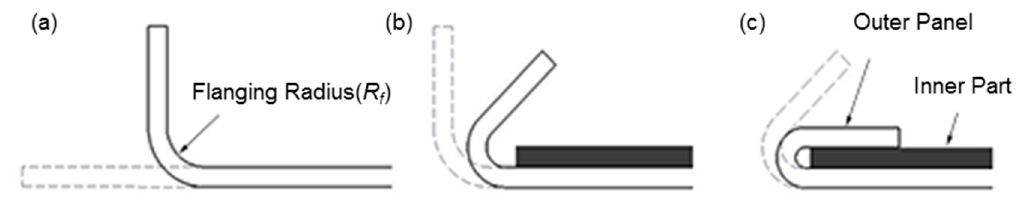
Figure 1. Steps in the hemming process: ( a ) flanging; ( b ) pre-hemming; and ( c ) final hemming.